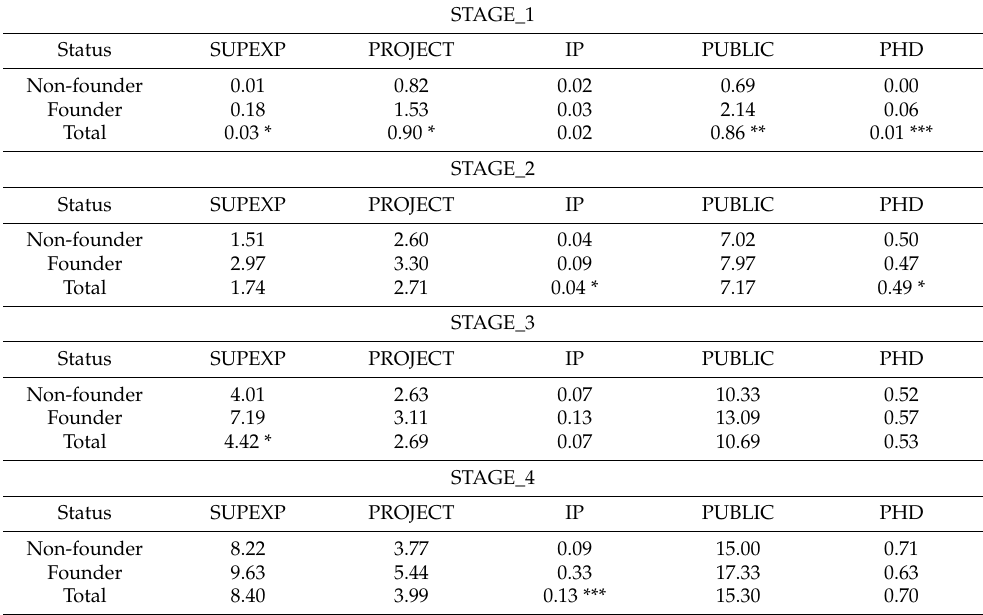
Table 3. Means of independent variables with statistical tests.